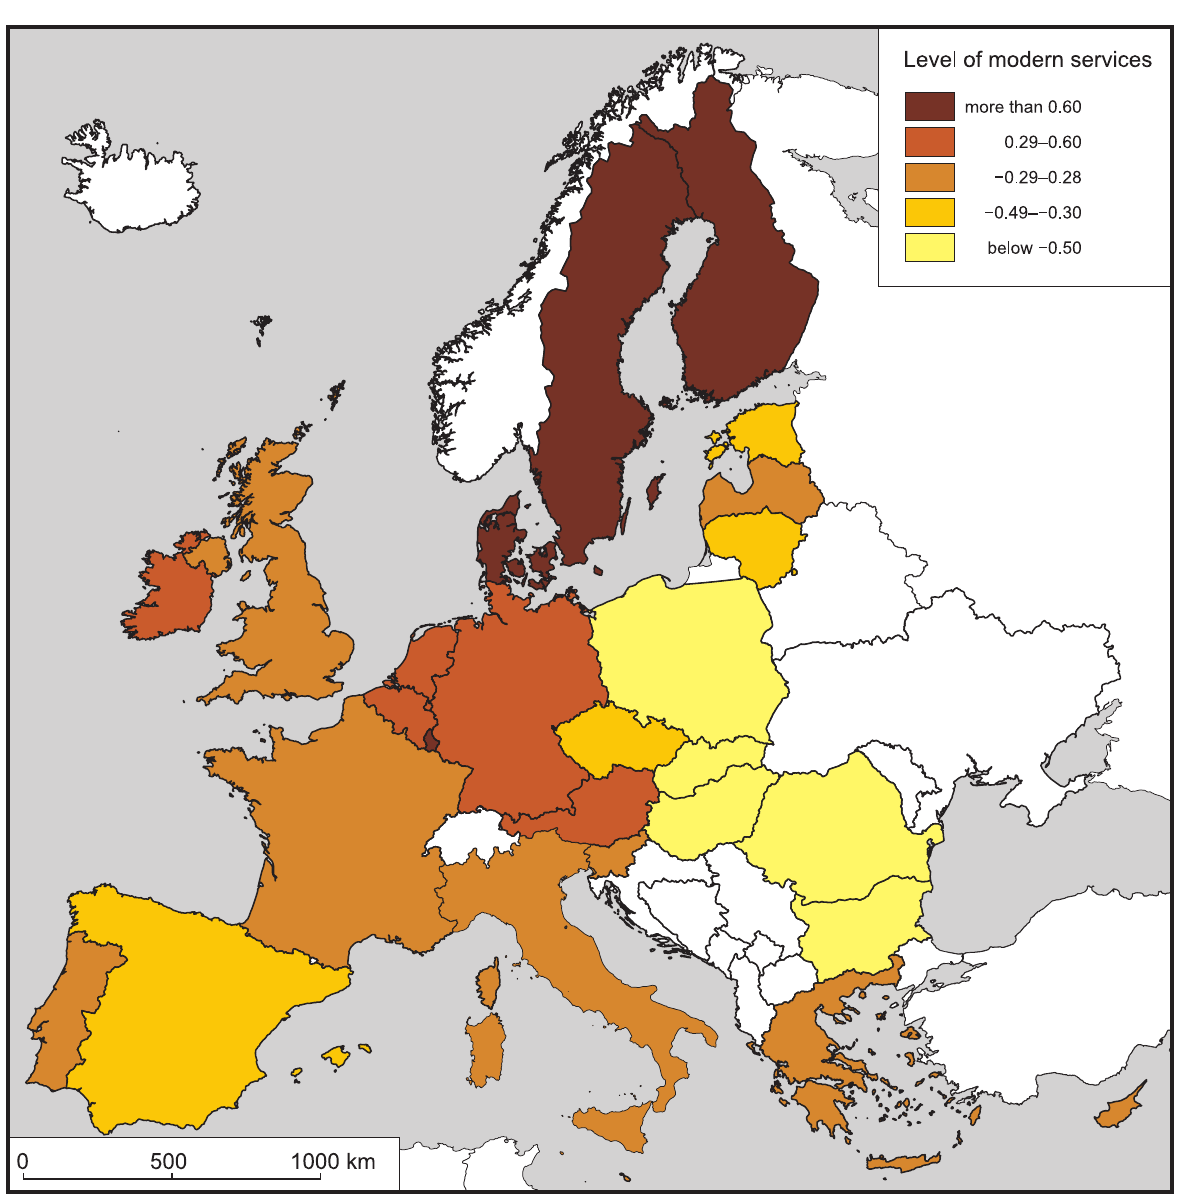
Fig. 2. The level of development of modern services in the EU member states in 2014. Source: own study based on data from the Eurostat